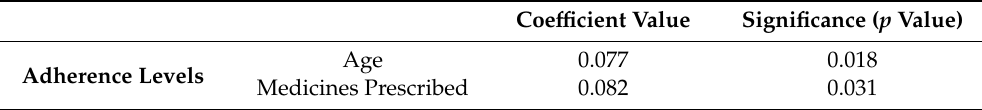
Table 6. Spearman correlation between adherence level and age and medicines prescribed.